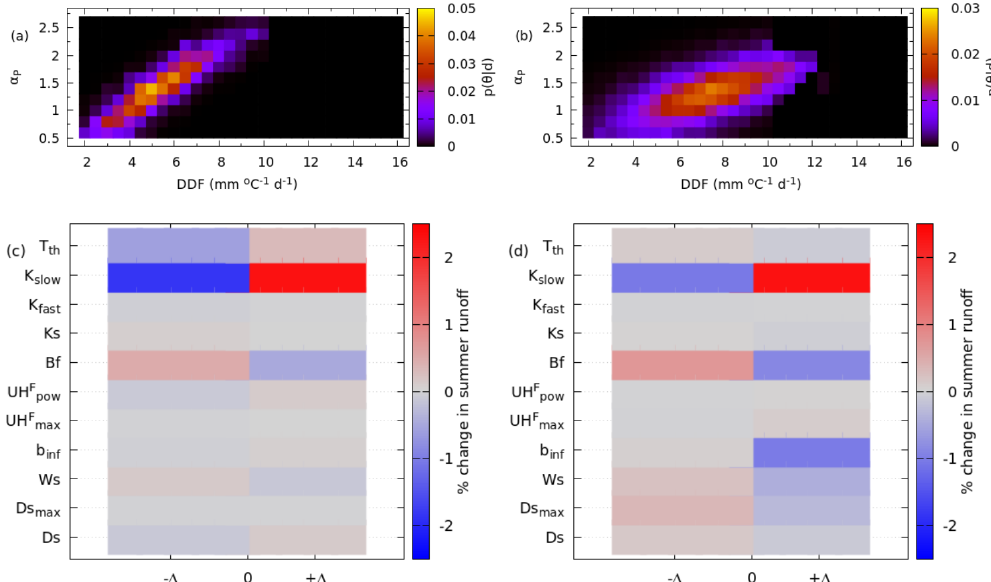
Figure 4. Panels (a) and (b) show the posterior probability distribution p(θ | d) of the model parameters ( α P , DDF) for the Chandra and upper Dushkoshi catchments, respectively (see Sects. 3.2.3 and 4.1). Panels (c) and (d) show the sensitivities of the simulated summer runoff to perturbations in 11 uncalibrated model parameters for the Chandra and upper Dushkoshi catchments, respectively. Here, ± (cid:49) denotes the perturbation of parameters by ± 25% of the corresponding prescribed range (see Sect. 3.2.4, and Table